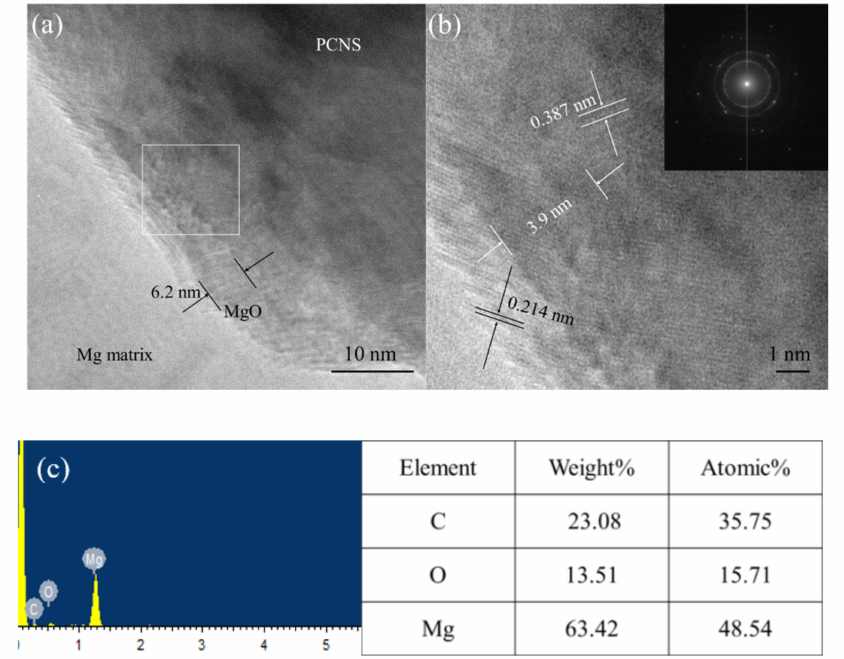
Figure 9. HRTEM image of ( a ) 2PCNS@O / Mg sample, ( b ) the enlarged image of the box in a and ( c ) the EDS results of the enlarged box